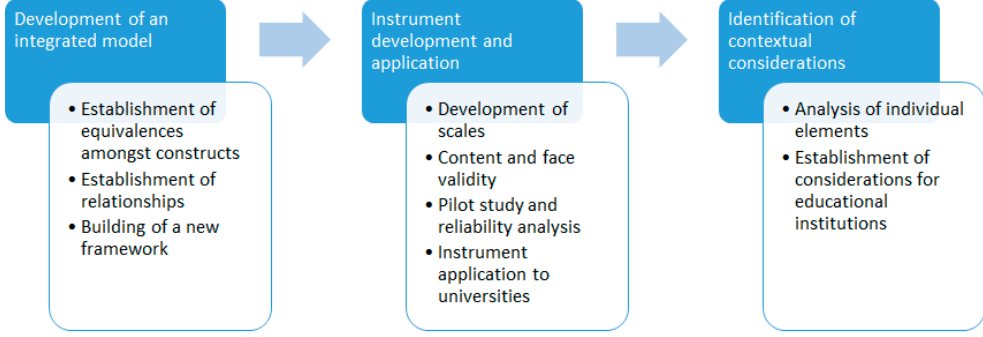
Figure 1. General methodology.